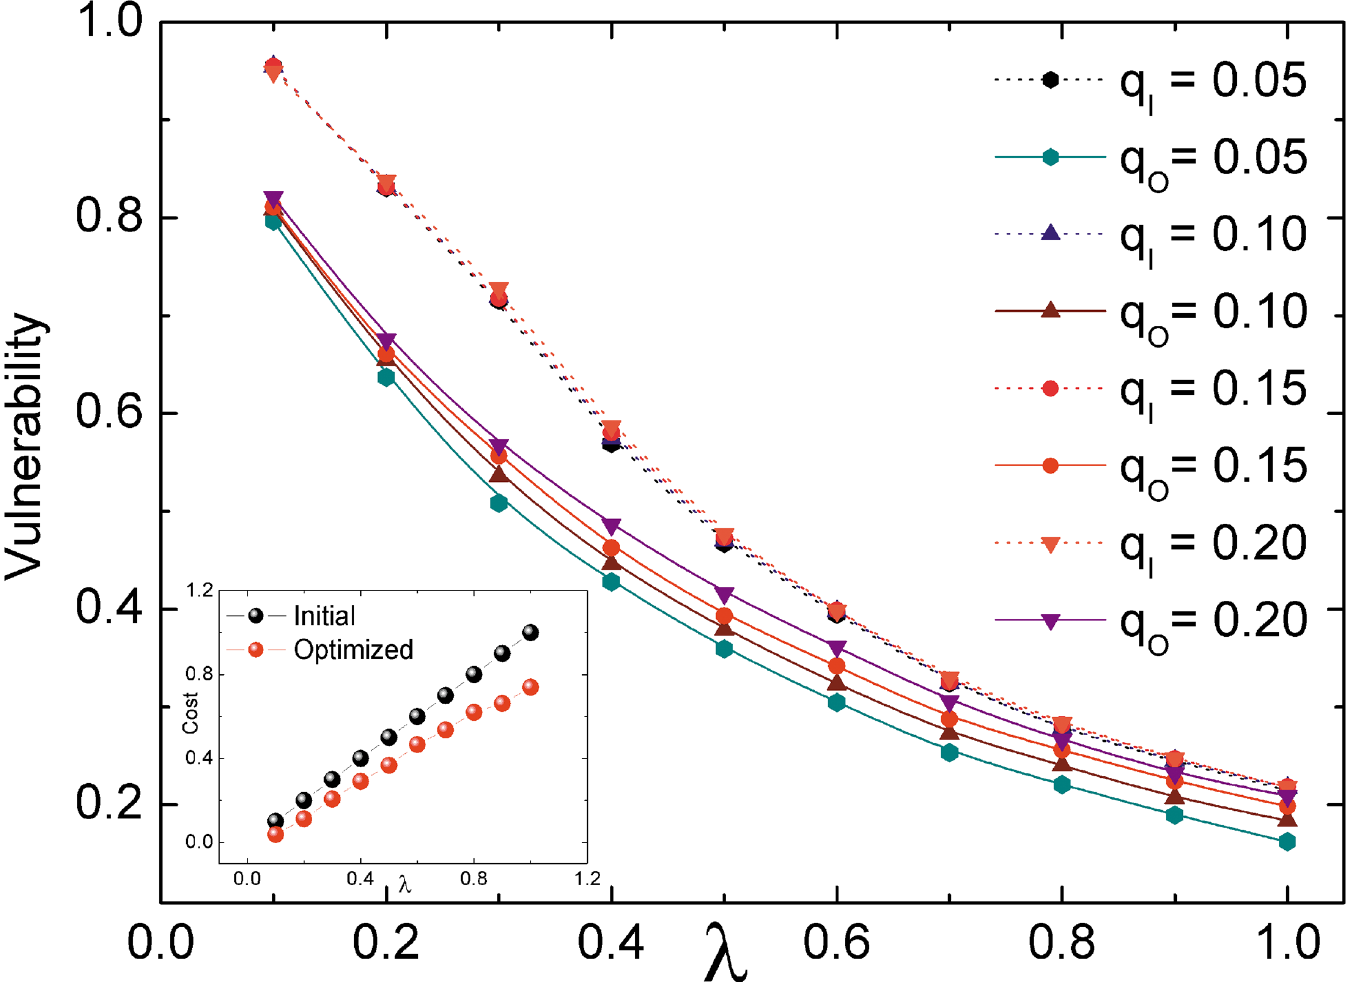
Fig 5. The effect of noise. The dot lines represent the initial networks and the solid lines represent the optimized networks. Each point is averaged from 20 different networks. The adjusting parameter is set to ω =